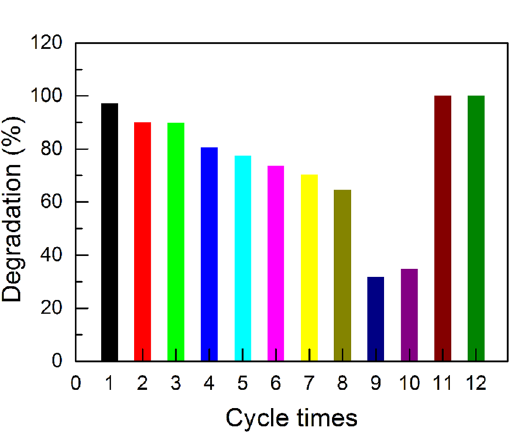
Figure 7. ( a ) Normalized concentration C t /C 0 of RhB as a function of illumination time for Blank and different samples, ( b ) the UV-vis absorption spectra of RhB in the presence of γ -Fe 2 O 3 @SiO 2 @TiO 2 sample as a function of illumination time.